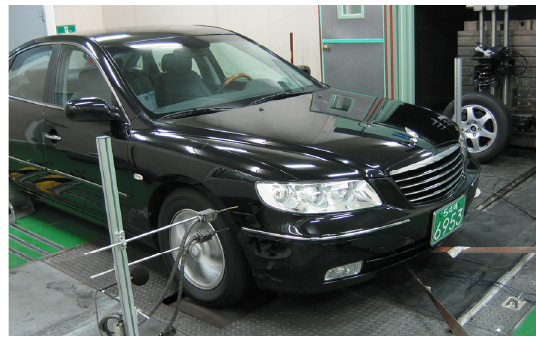
Figure 11. Configuration of chassis noise dynamometer test.